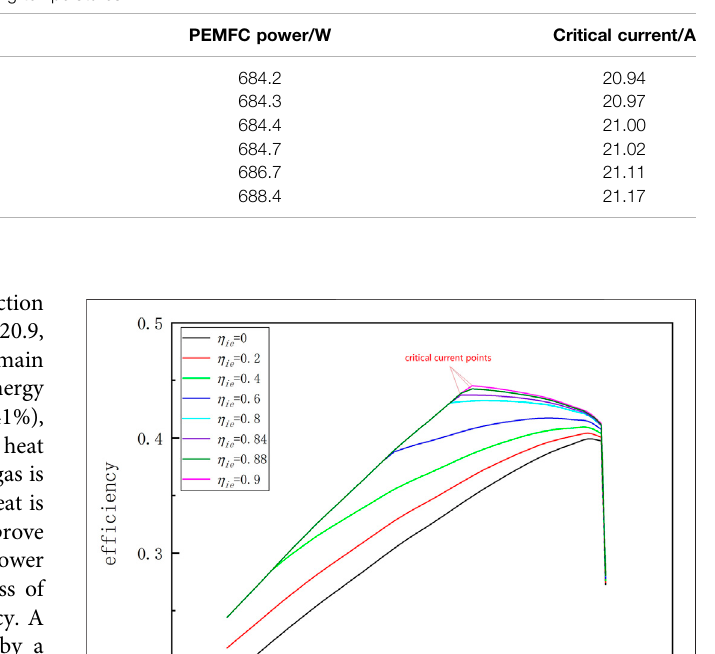
TABLE 5 | Output characteristics of the system at different PEMFC operating temperatures.